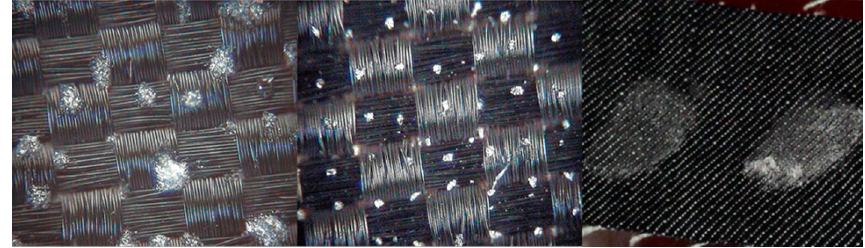
Figure 1. Ammonium nitrate ( left , 400 μ g/cm 2 ), urea nitrate ( center , 400 μ g/cm 2 ) deposited on synthetic fabrics with the piezoelectric Nano-Plotter™ and fingerprints of TNT on denim ( right ).